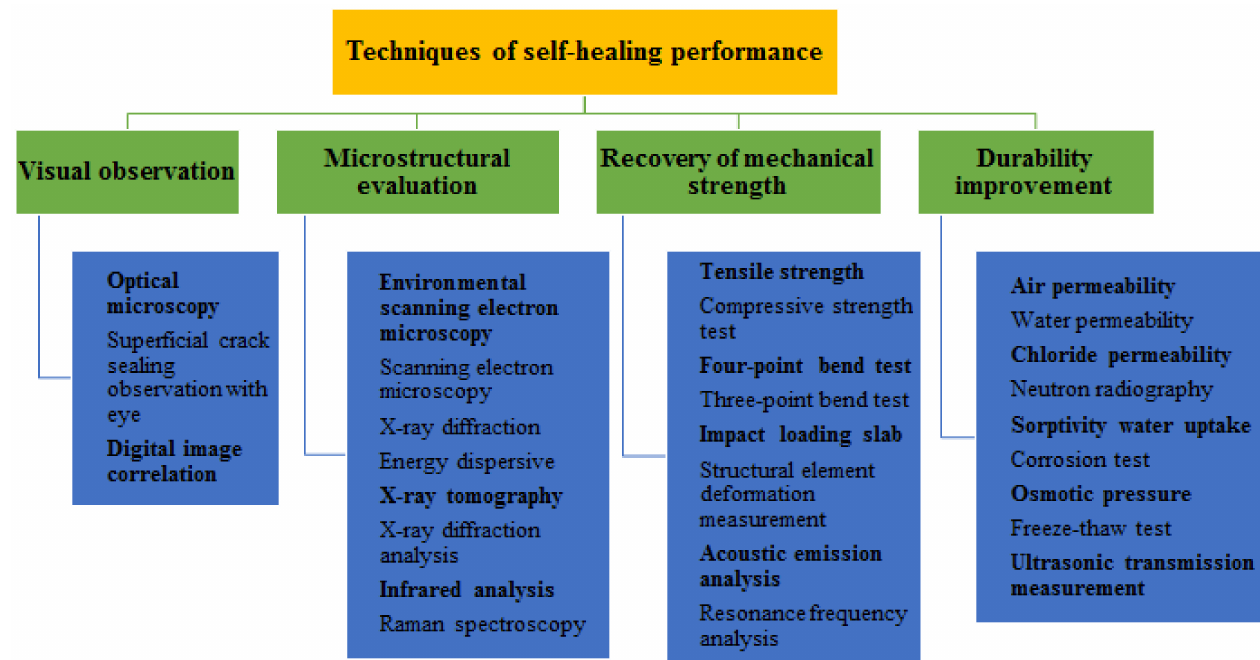
Figure 10. Techniques for measuring self-healing performance in